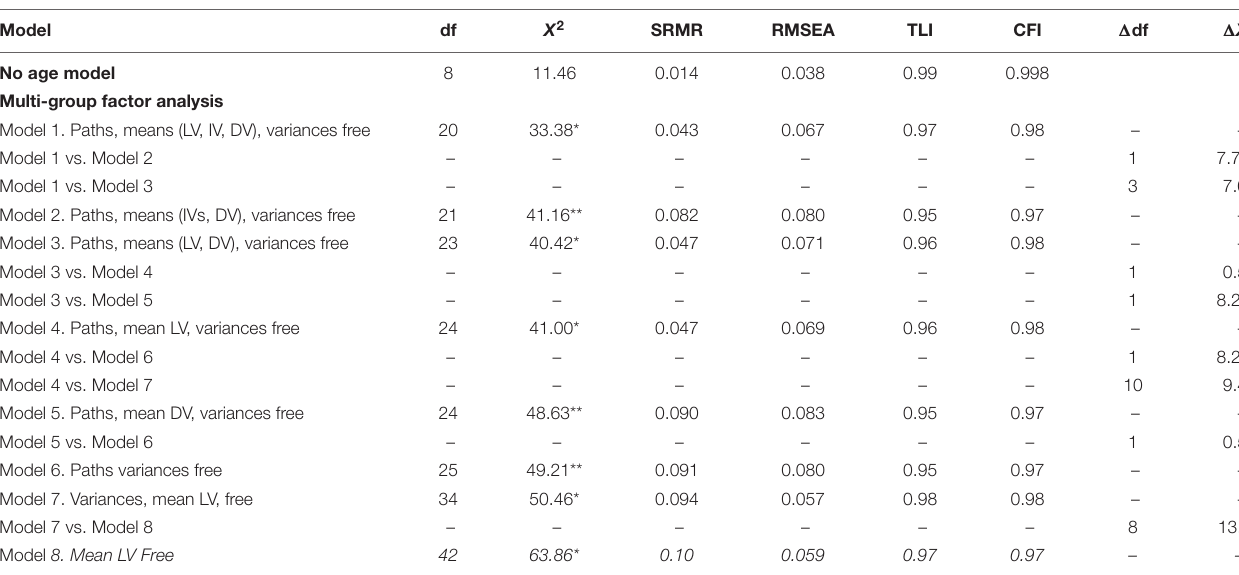
FIGURE 2 | SEM for health for the full sample. All paths are denoted with the standardized beta. * p < 0.05, ** p < 0.01. TABLE 4 | Results of structural equation models for